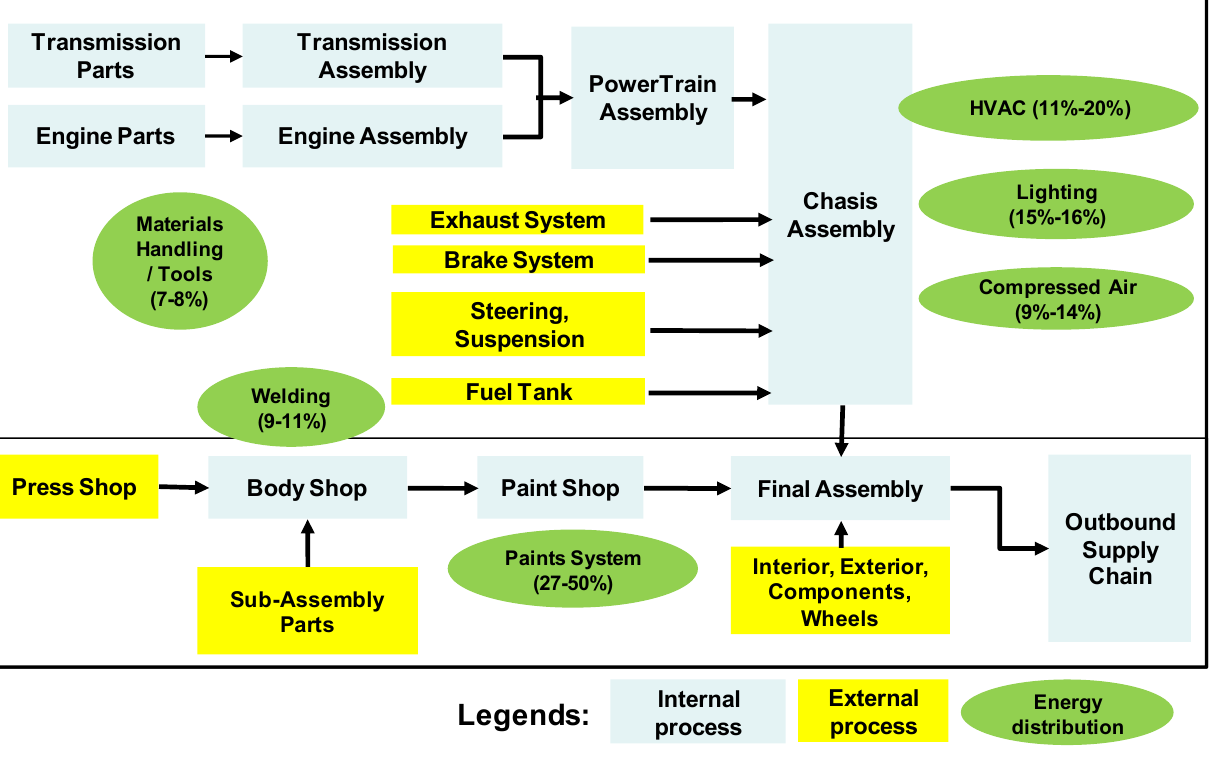
Figure 6 associates automotive manufacturing operations with the distribution of their energy use. Four identified largest energy-consuming operations are painting (27%–50%), HVAC and lighting (11%–20% and 15%–16%, respectively), and compressed air (9%–14%). Figure 6. A typical vehicle assembly process and its energy distribution (modified from